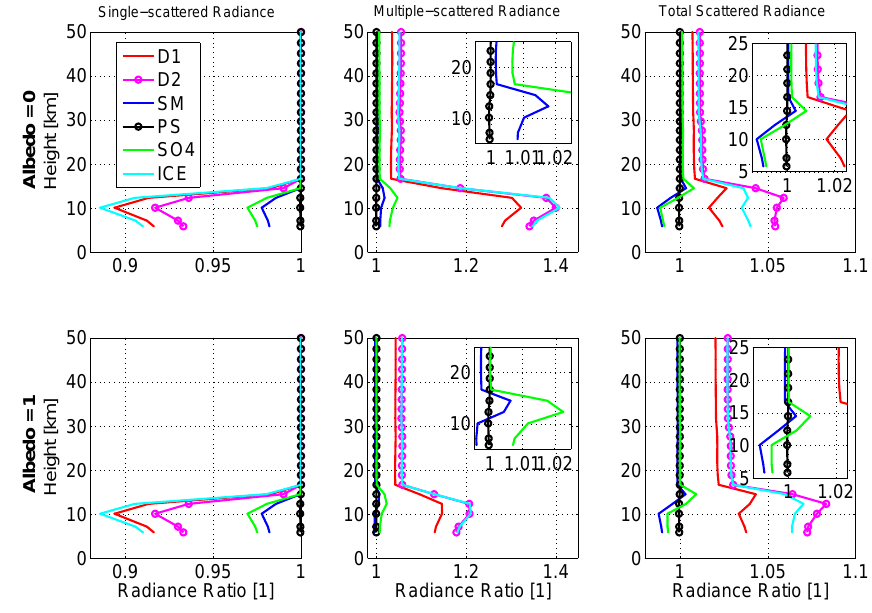
Fig. 9. As in Fig. 7 but at